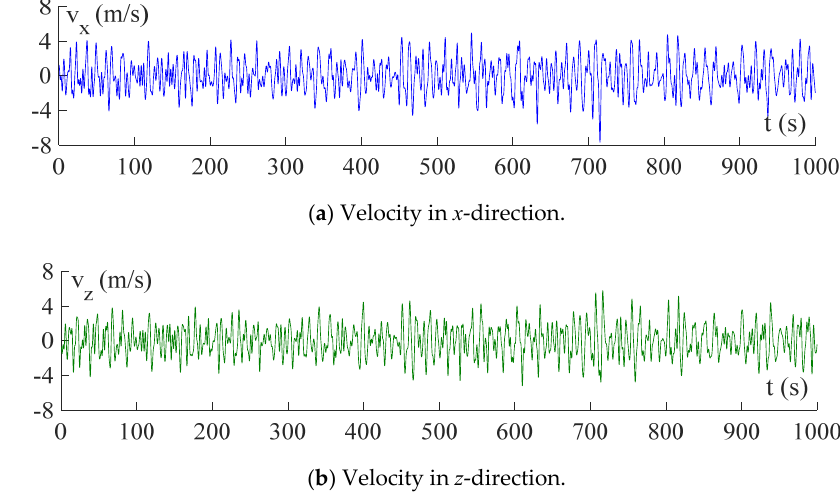
Figure 7. Samples of wave-particle velocities on the sea surface.